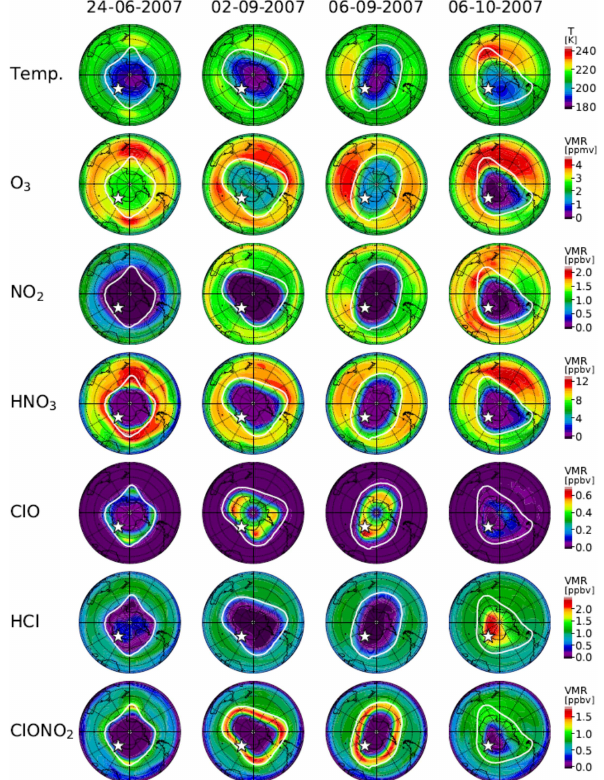
Figure 14. Same as Fig. 13 but for 5 July (day 186), 19 August (day 231), 21 August (day 233), and 9 October (day 282), 2011. The polar vortex edge on 5 July plotted by a dotted while outline indicates that the inner vortex edge was defined on this